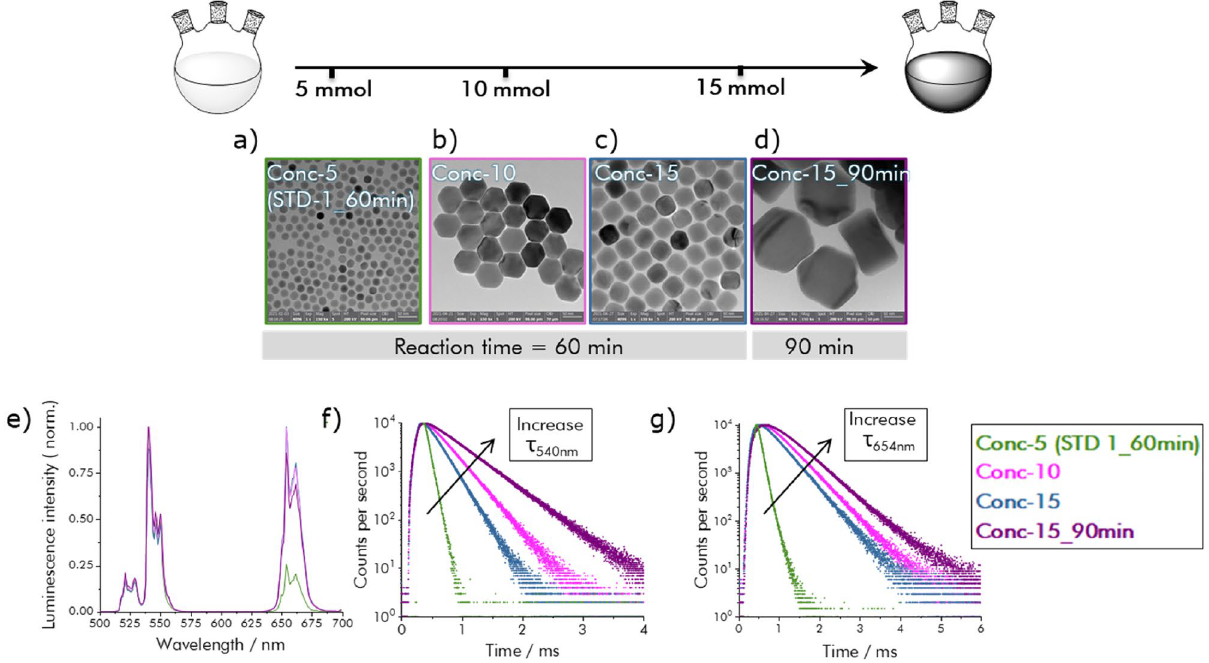
Figure 5. ( a – d ) TEM images of NaYF 4 nanocrystals co-doped with 20% Yb 3+ and 2% Er 3+ synthesized by increasing the RE precurcors concentration in a constant solvent volume (120 mL): 5 mmol, 10 mmol, and 15 mmol LnCl 3 ; for TEM images with higher resolution: see SI, Fig. S1k,w–y; ( e ) UCL emission spectra of NaYF 4 : x % Yb 3+ , 2% Er 3+ UCNPs under 980 nm excitation; ( f ) Decay kinetics of the 540 nm Er 3+ emission; ( g ) Decay kinetics of the 654 nm Er 3+